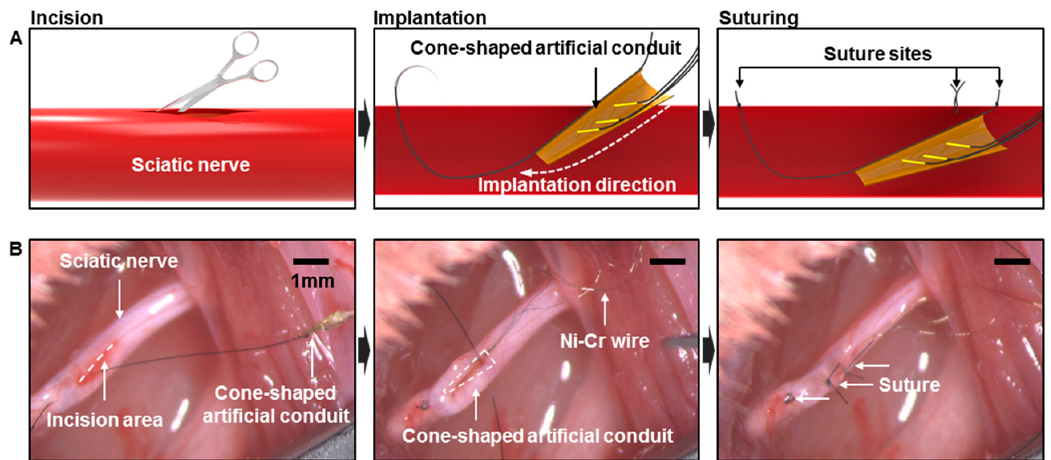
Figure 3. Implantation process of wire electrodes with the artificial conduit. ( A ) Schematics of the implantation process. ( B ) in vivo images of the implantation process. Longitudinal incision of the sciatic nerve and implantation of the conduit using the suture thread, fixation of the conduit by